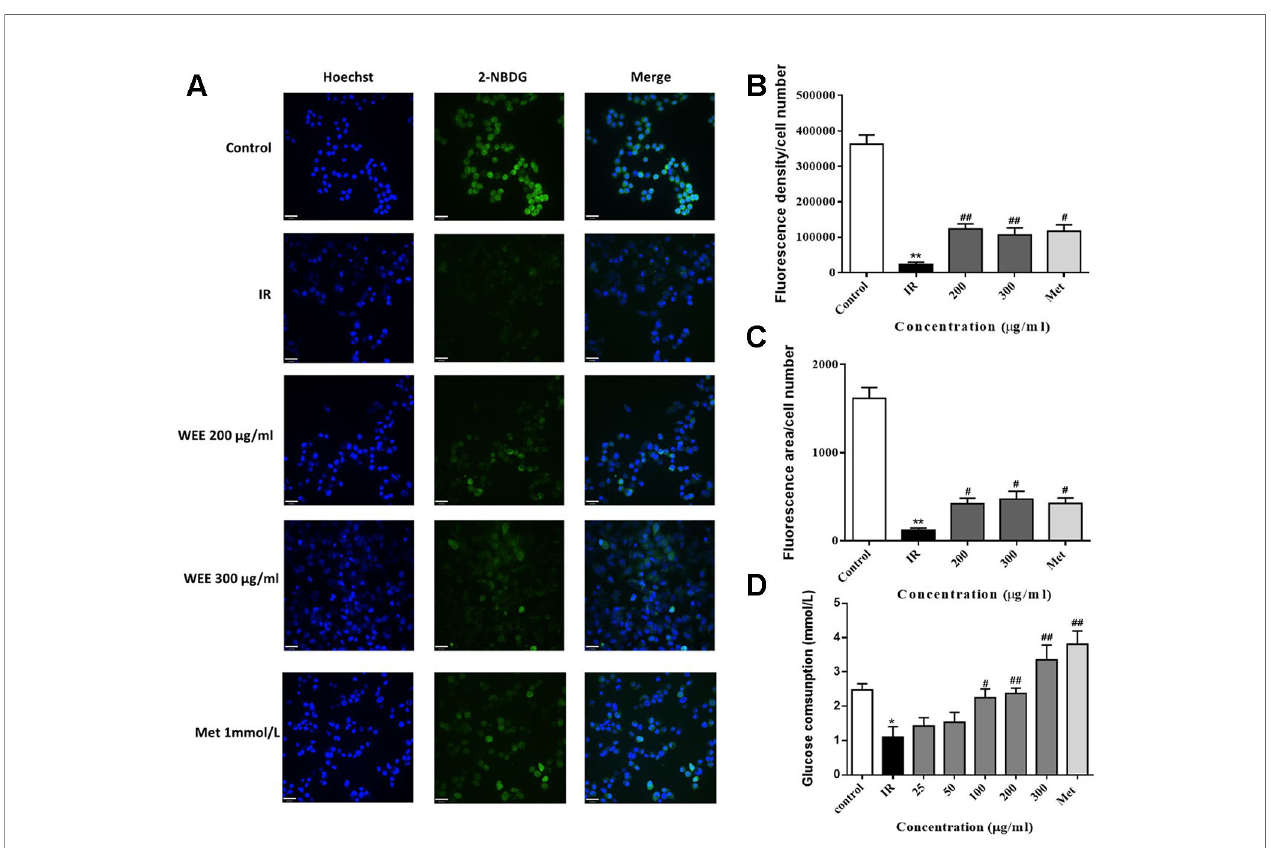
FIGURE 3 | WEE elevated the glucose uptake and consumption in PA-induced HepG2 cells HepG2 cells were incubated with normal glucose (5.5 mM) or high glucose (30 mM) in the absence or presence of WEE (200 and 300 m g/ml) or metformin (165 m g/ml) for 24 h and incubated with insulin (100 nM) for another 30 min. The glucose uptake was then detected by 2-NDBG assay, and the nuclear was stained by Hoechst (A) . The fl uorescence intensity and area were analyzed using Image J software assays (B , C) . After 24 h treatment followed by incubation with insulin (100 nM) for 30 min, cells were incubated with RPMI-1640 containing 11.1 mmol/L glucose for 24 h. The glucose contents in the culture medium were determined by glucose assay kit (D) . Data presented in bar charts are mean ± SEM values from six independent experiments. Groups are signi fi cantly different from the control group at *p < 0.05, **p < 0.01. The groups are signi fi cantly different from the IR group at # p < 0.05 and ## p < 0.01 determined by Dunnett ’ s multiple comparisons test. The bar in each photograph indicates 33 m